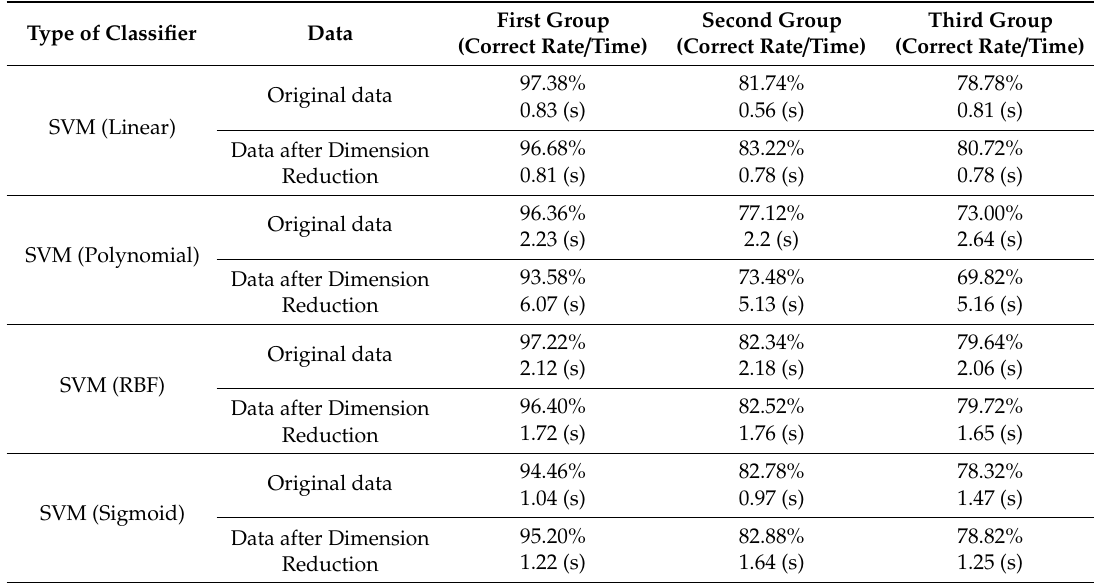
Table 2. Training and detection results for each SVM kernel